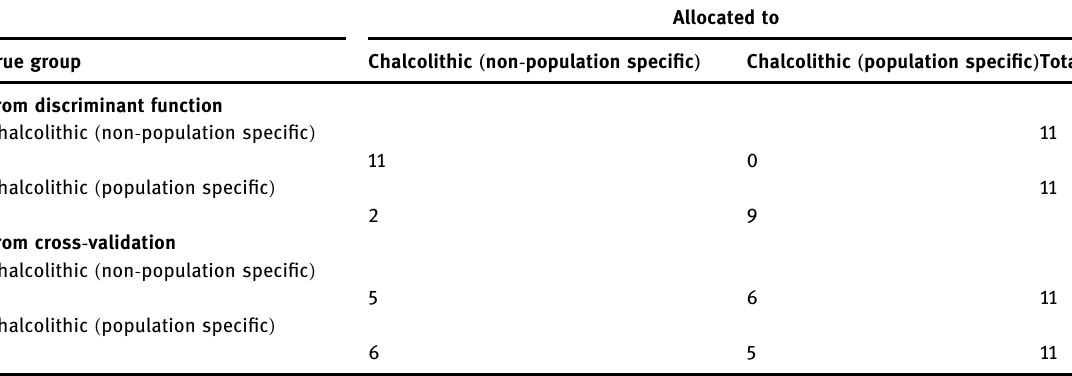
Table A2: DFA with cross - validation of the non - population - speci fi c reconstructed Chalcolithic sample vs the population - speci fi c reconstructed Chalcolithic sample ( see details about reconstruction parameters in Materials and Methods )